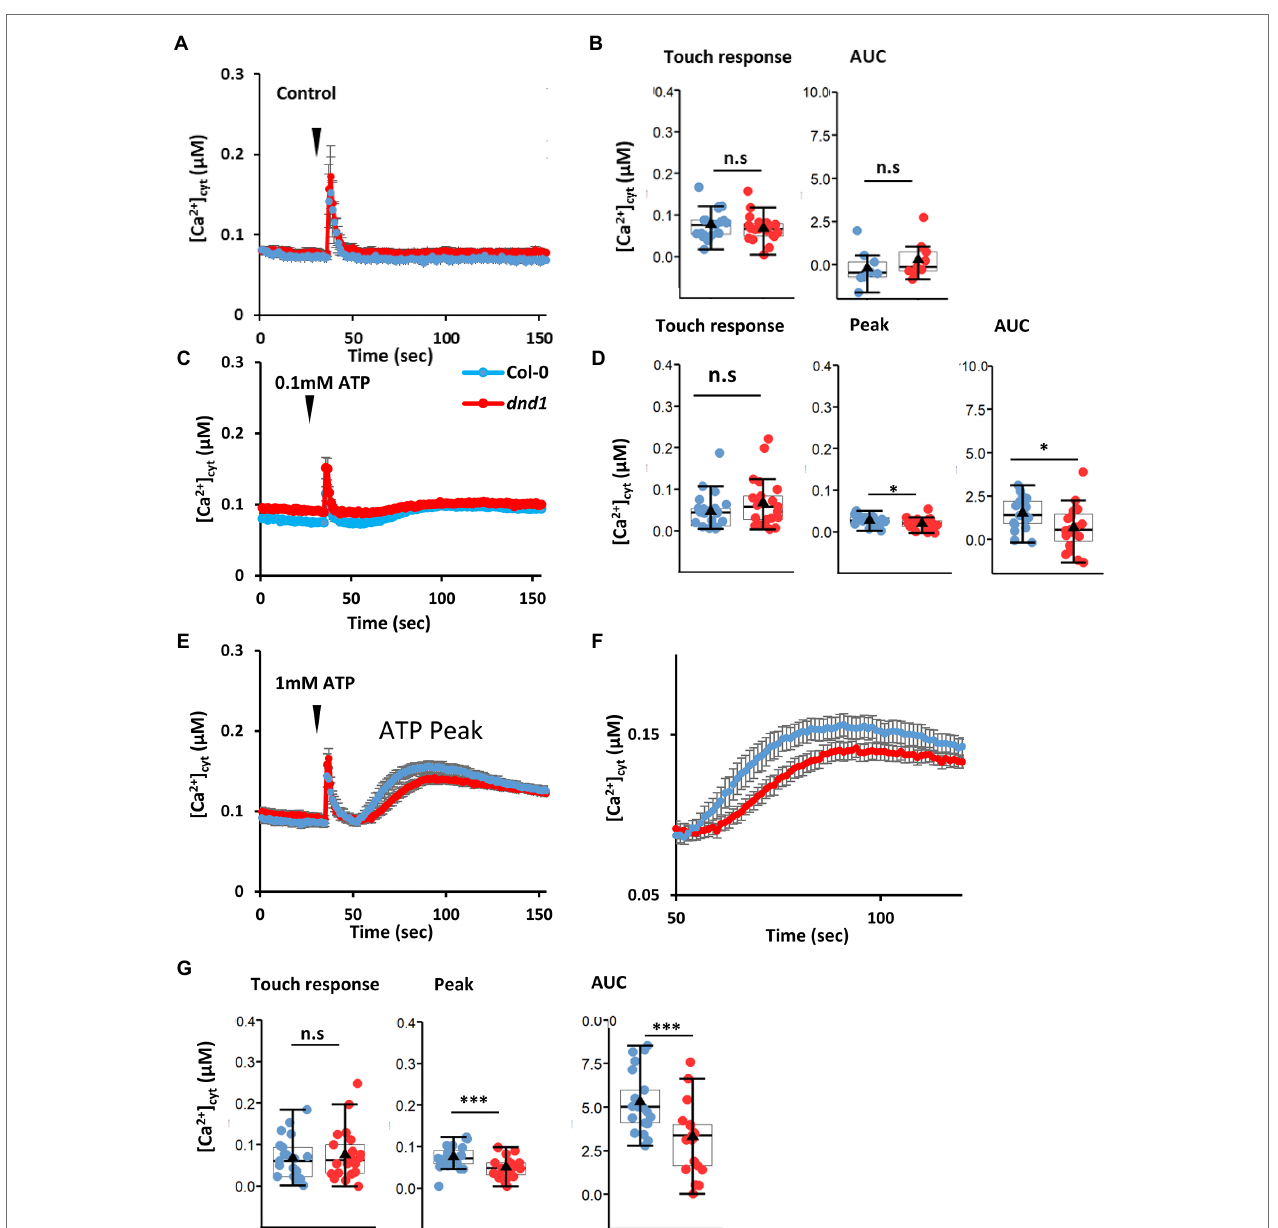
FIGURE 2 | The defense not death 1 ( dnd1 ) mutant has an impaired [Ca 2+ ] cyt response to eATP. Cotyledons were excised from 14-day-old Col-0 and dnd1 ; cytosolic aequorin was reconstituted with coelenterazine (in 10 mM CaCl 2 , 0.1 mM KCl, 2 mM Tris/MES, pH 5.8) as described by Mohammad-Sidik et al. (2021). Luminescence was recorded from individual samples bathed in 10 mM CaCl 2 , 0.1 mM KCl, 2 mM Tris/MES, pH 5.8 as described by Mohammad-Sidik et al. (2021). As with flg22, ATP causes pronounced acidification of solutions, and so in this study, pH of eATP test solutions was maintained by buffers to avoid acidic pH artefactual responses which can impair interpretation (Westphal et al., 2019). [Ca 2+ ] cyt values were calculated as described by Matthus et al. (2019b). (A) Mean ± SEM time course of [Ca 2+ ] cyt response of Col-0 and dnd1 to control solution (10 mM CaCl 2 , 0.1 mM KCl, 2 mM Tris/MES, pH 5.8) added at 35 s (inverted triangle). (B) Touch-induced [Ca 2+ ] cyt increase from pre-stimulus baseline and estimated total [Ca 2+ ] cyt mobilized [area under the curve (AUC), after baseline subtraction]. (C) Mean ± SEM time course of [Ca 2+ ] cyt response of Col-0 and dnd1 to 0.1 mM eATP added at 35 s (inverted triangle). (D) Touch-induced [Ca 2+ ] cyt increase from pre-stimulus baseline, peak eATP-induced [Ca 2+ ] cyt increase from baseline, and estimated AUC. (E) As (C) but with 1 mM eATP. (F) Mean ± SEM time course of the eATP response shown in (E) . (G) As (D) but for 1 mM eATP. Results are from 3 independent trials with 9 samples in total per genotype in control trials and 19–21 samples in total per genotype in eATP trials. Each dot in box plots represents an individual recording. The middle line and the triangle in the box plot are the median and mean, respectively. Student’s t -test was used for analyzing statistical difference ( *** p < 0.001; * p < 0.05; n.s, not